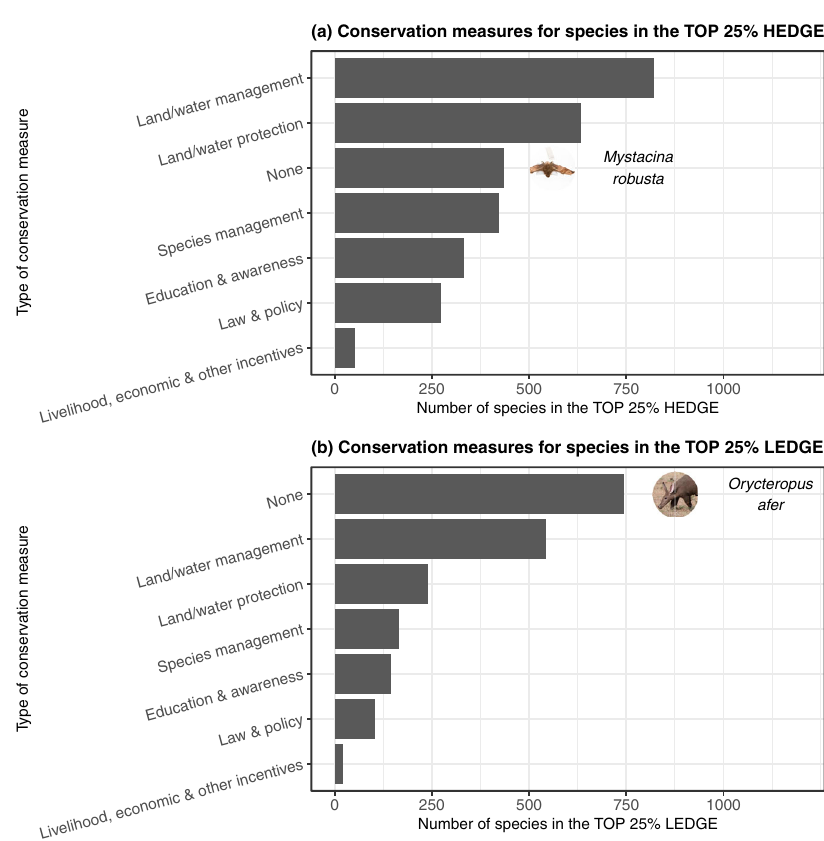
Fig. 5 Conservation measures of the species of interest for conserving global mammalian PD. Conservation measures for the TOP 25% HEDGE species ( a ) and the TOP 25% LEDGE species ( b ). The images illustrate examples of unprotected species. The image for Mystacina robusta has been modi fi ed from https://www.inaturalist.org/photos/13050710 (attribution: Auckland Museum, license: CC BY 4.0, some rights reserved). The image for Orycteropus afer has been modi fi ed from https://www.inaturalist.org/photos/78448701 (attribution: Dave Brown, license: CC0 1.0, no copyright). Source data are provided as a Source Data fi le.